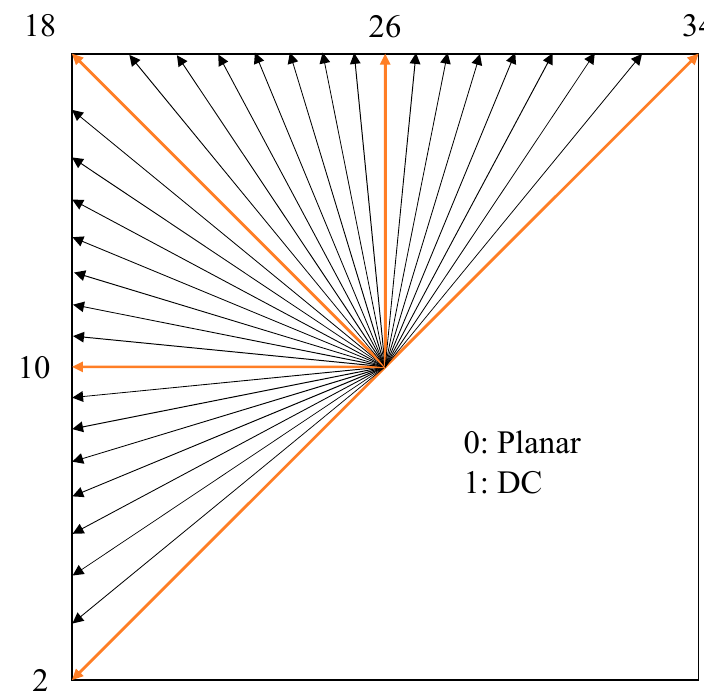
Figure 1. Illustration of intra modes in High Efficiency Video Coding (HEVC).